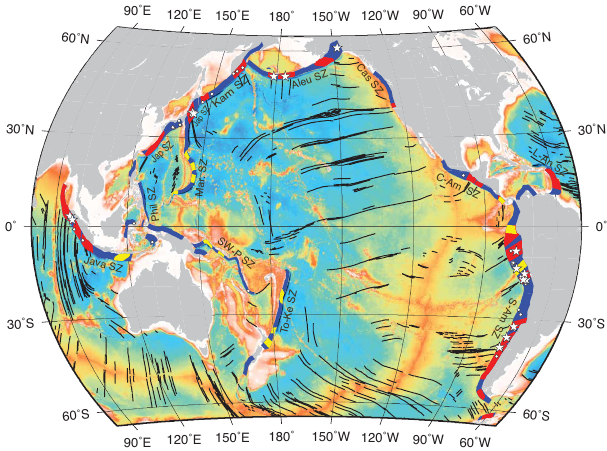
Fig. 5. ETOPO1 global relief map (Robinson projection) with oceanic fracture zones shown as black lines. Global subduction coupling zone (solid blue regions) is overlain with fracture zone- subduction zone intersection regions (solid red bands), significantly more prone to great earthquakes than the blue bands, based on our analysis. Intersections between volcanic chains/ridges (solid yellow bands) are biased towards an above-average occurrence of smaller earthquakes, but this result is more uncertain due to the relatively small number of these intersections. Overlain are the largest 15 in- strumentally recorded earthquakes (Mw = 8.6) (white filled stars) and the largest 50 earthquakes (Mw = 8.4) (while filled circles). Subduction zone labels as in Fig.